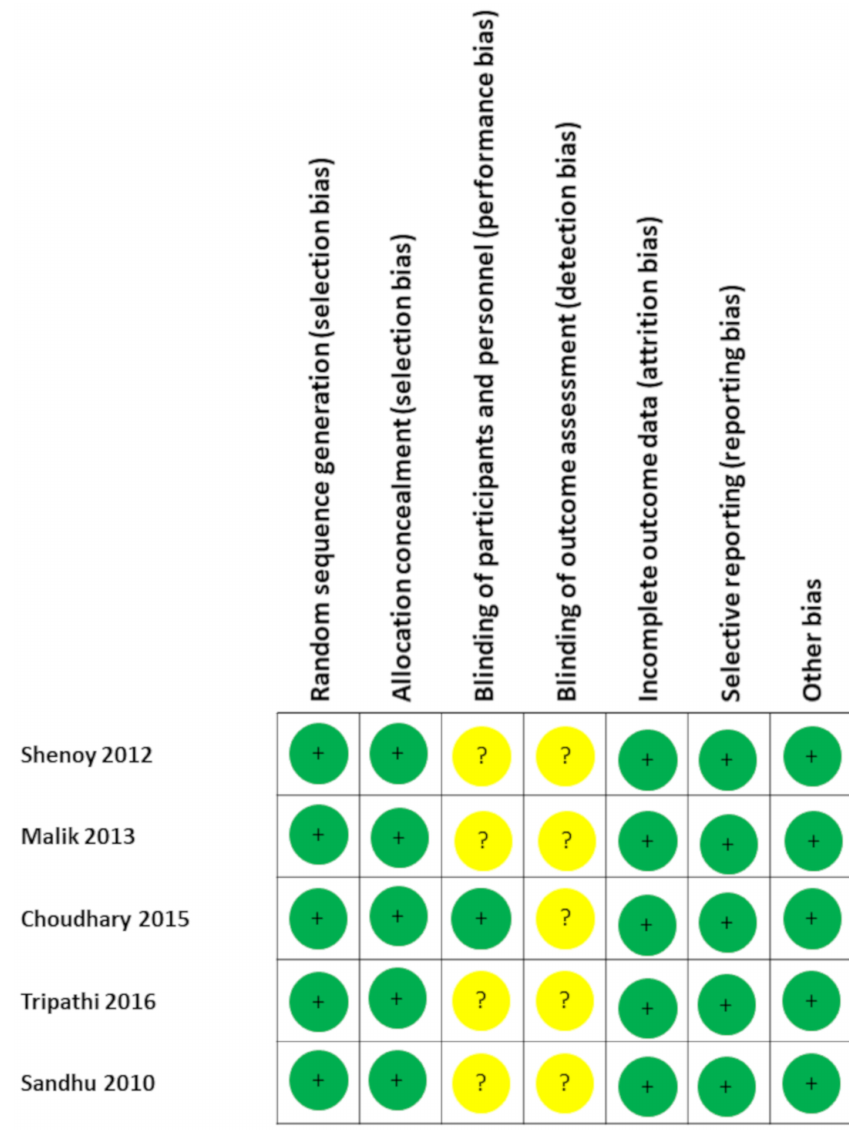
Figure 2. The Cochrane Collaboration’s tool for assessing risk of